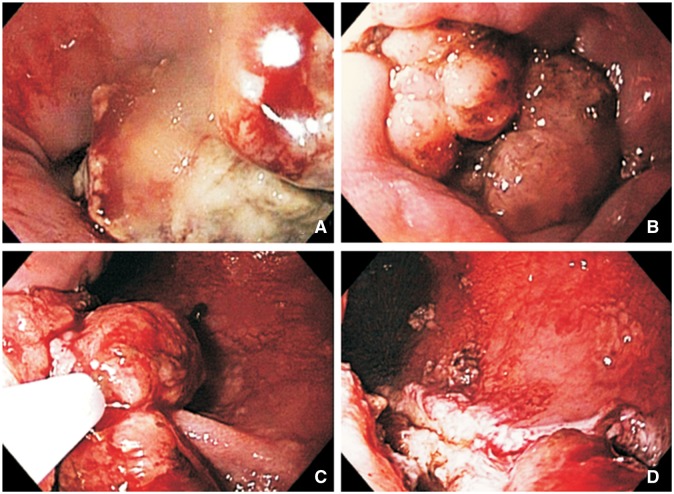
Endoscopic findings. (A) Lower esophagus showed two columns of tumor extending approximately 5 cm upstream from the gastroesophageal junction. (B) A bulky tumor causing a ball valve-like effect, obstructing the gastroesophageal junction. (C) Debulking was performed using a mini snare and a spiral snare. (D) Tumor burden was significantly decreased.